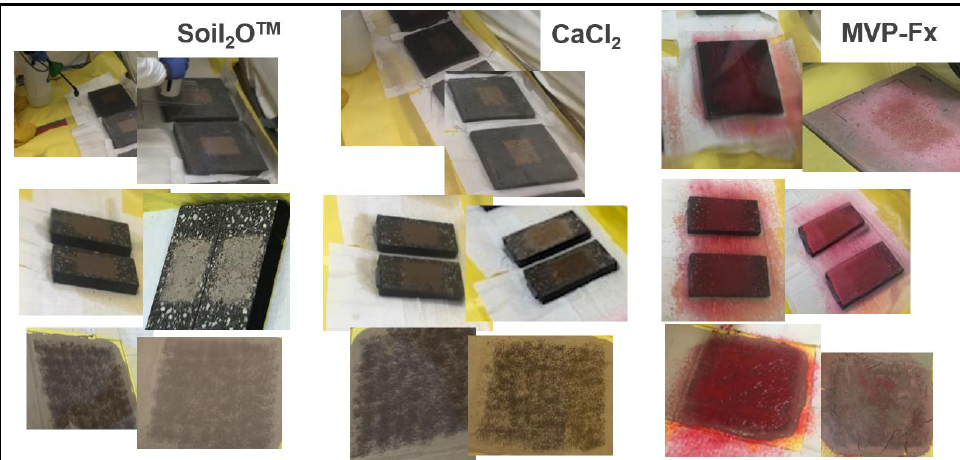
Figure 3. Surfaces Treated with Stabilization Technologies (Left: Wet; Right: Dry).